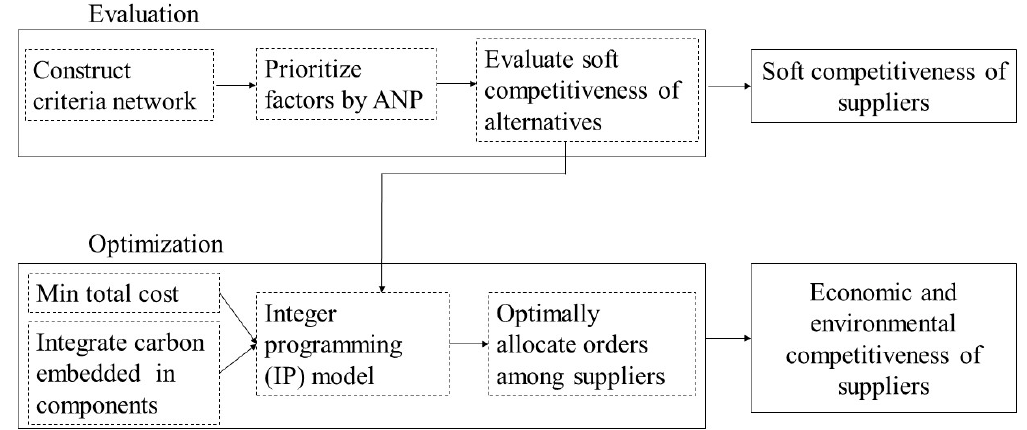
Figure 1. The framework of this paper.